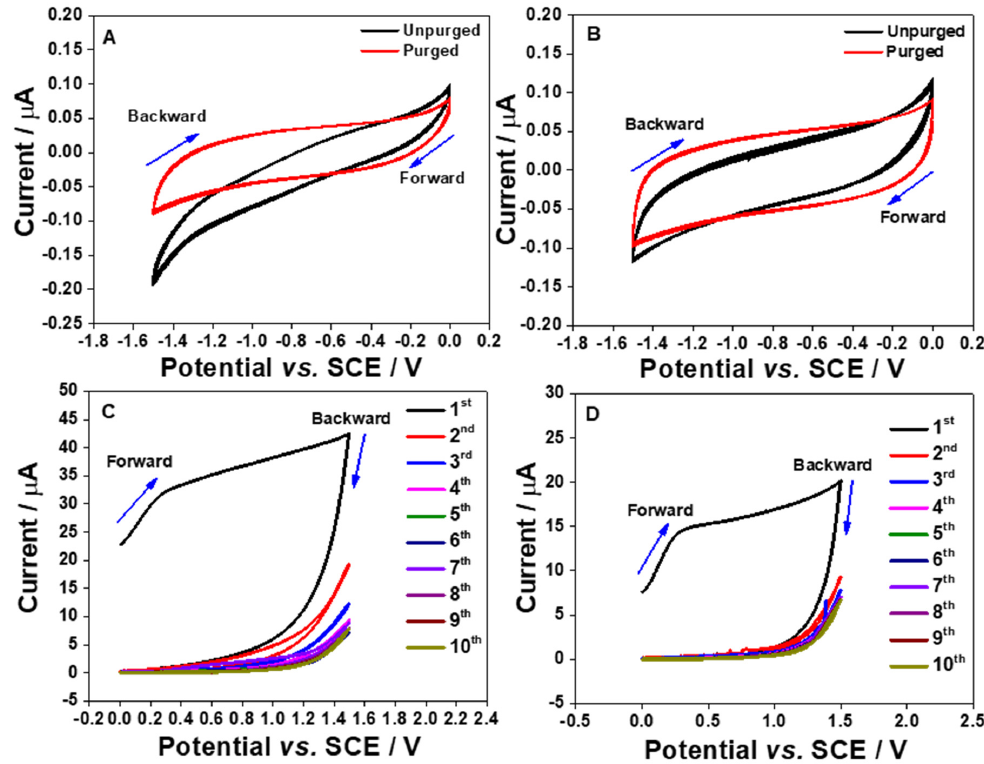
Figure 3. Cyclic voltammograms (10 cycles) of the S1 ( A , C ) and S2 ( B , D ) electrodes in an aerated and purged PB solutions (pH 7) at 100 mV s − 1 . The potential was cycled in the negative region ( A , B ) from 0 to − 1.5 V vs. SCE and in the positive region ( C , D ) between 0 and 1.5 V vs. SCE. Molecules 2020 , 25 , x FOR PEER REVIEW